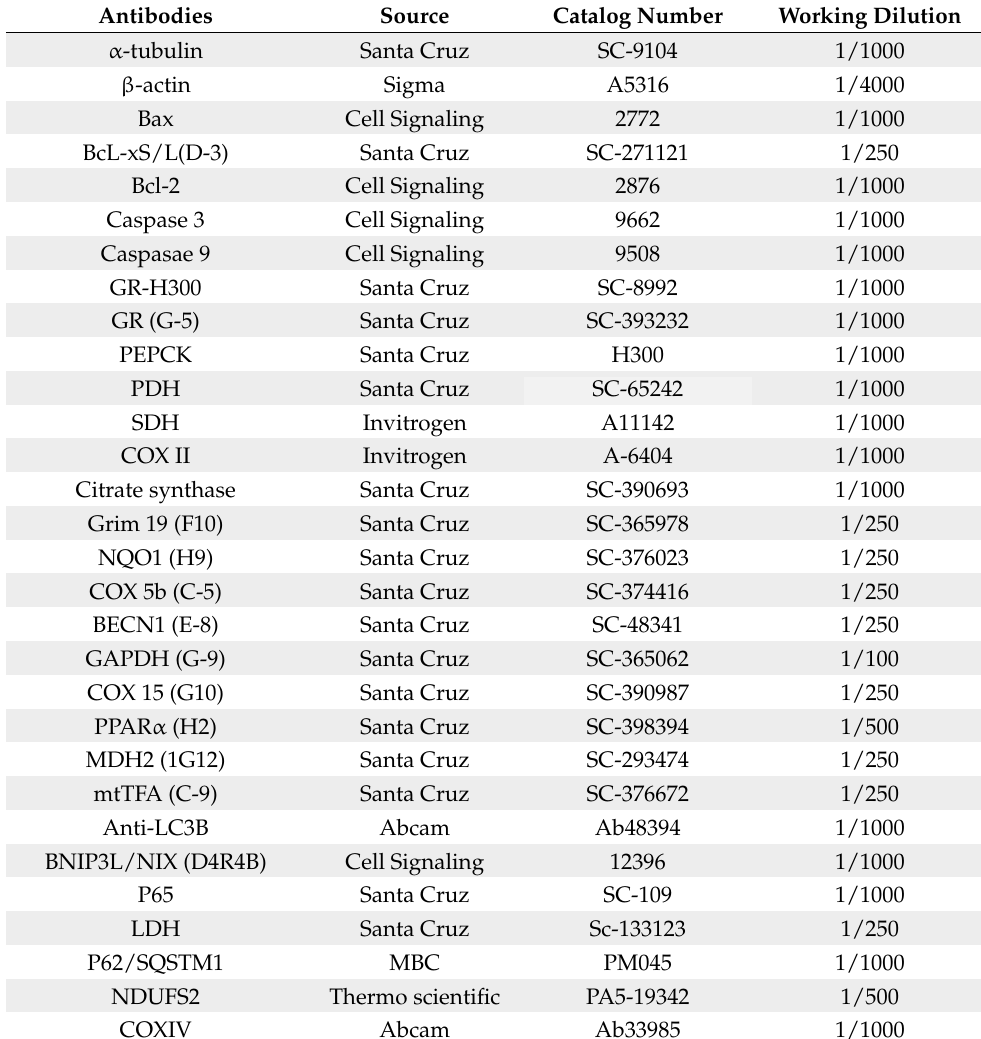
Table 1. List of antibodies used in Western blot analyses. Antibodies Source Catalog Number Working